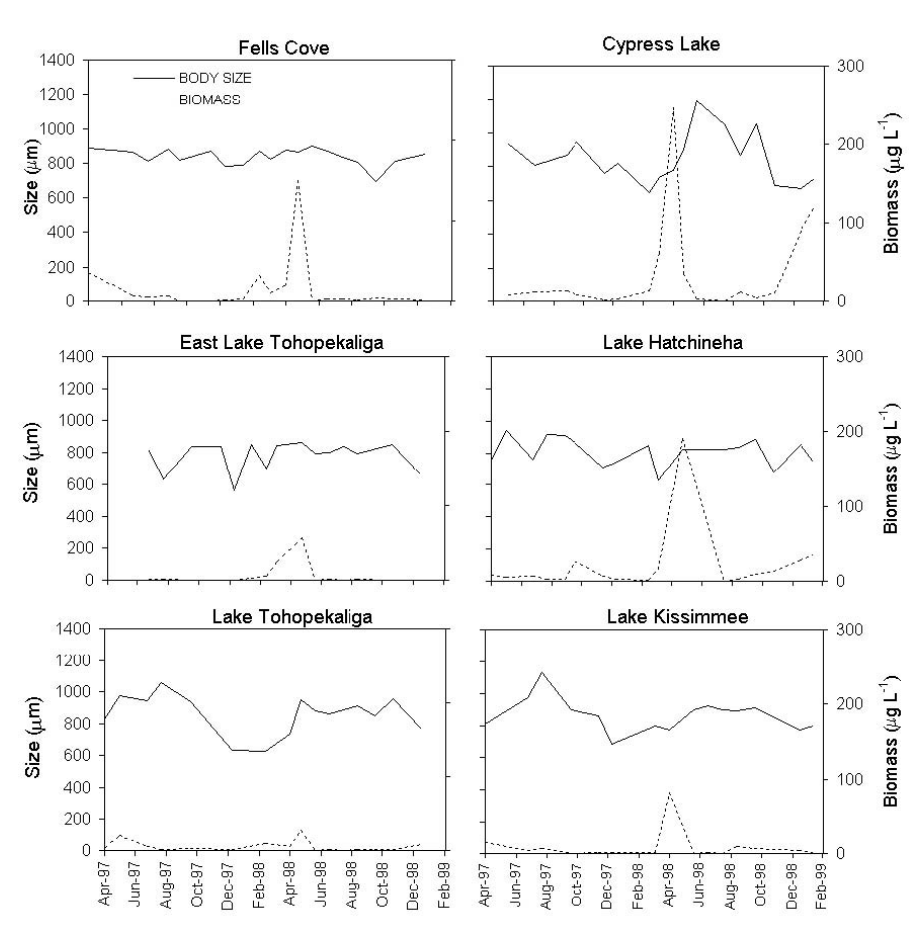
FIGURE 4 . Average body size and total community biomass of macro-zooplankton collected in vertical net tows in the Kissimmee Chain-of- Lakes during 1997 and